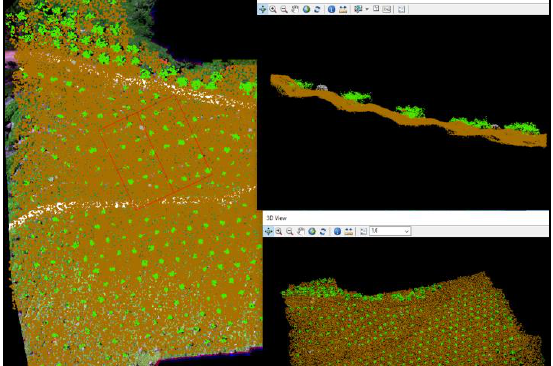
Figure 3. Classified Dense Point Clouds of Ground